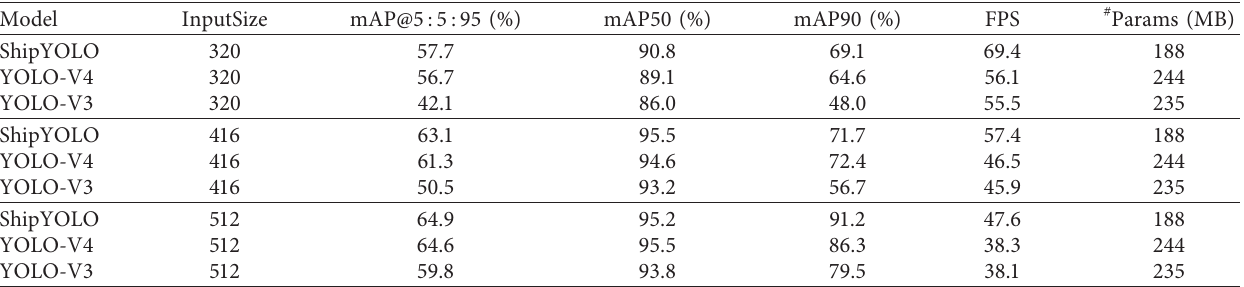
Table 2: Experimental results of